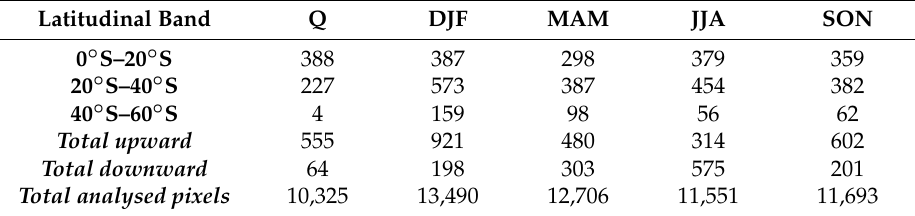
Table 1. Number of pixels with a significant monotonic trend (not necessarily linear) for the SO 2 seasonal concentrations in the lower troposphere